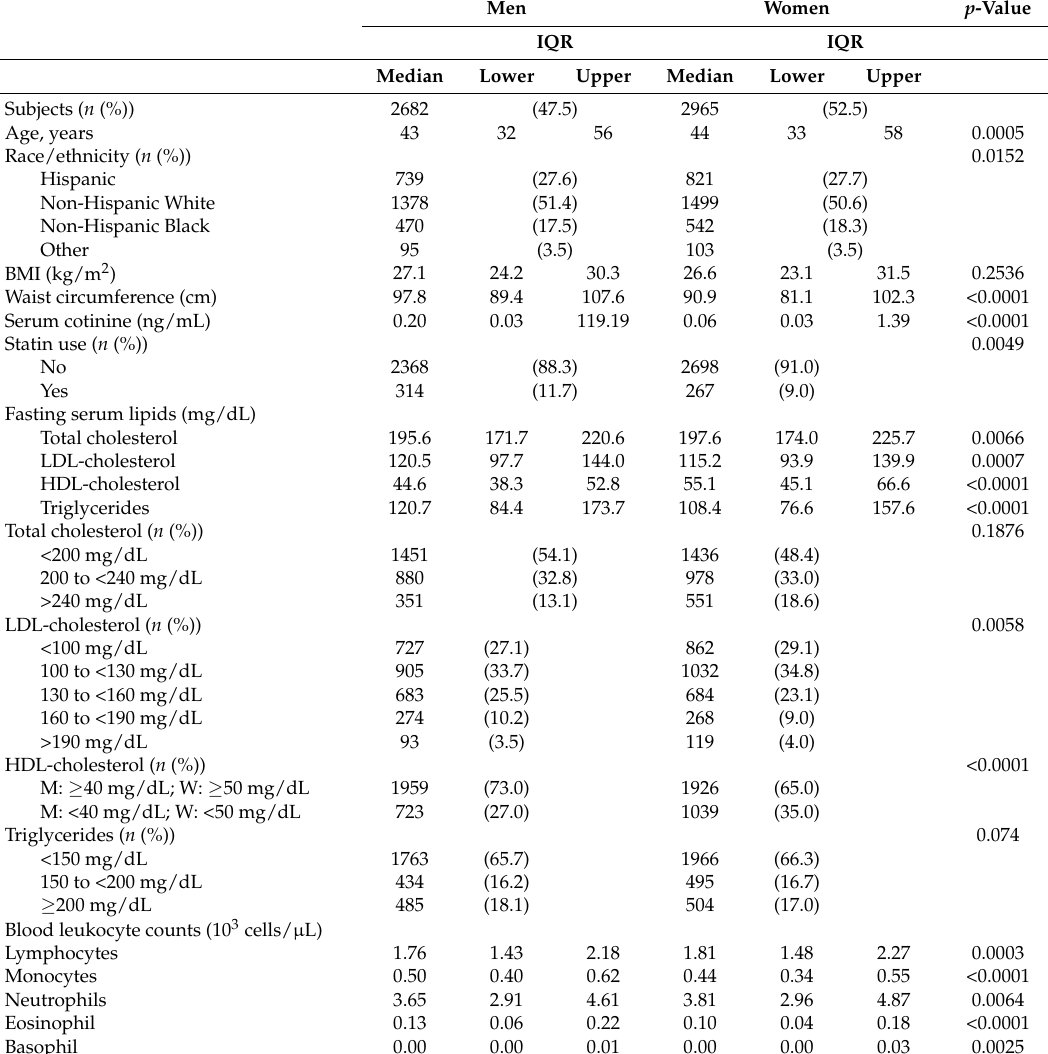
Table 1. Descriptive statistics of men and women in NHANES 1999–2004 ( n =